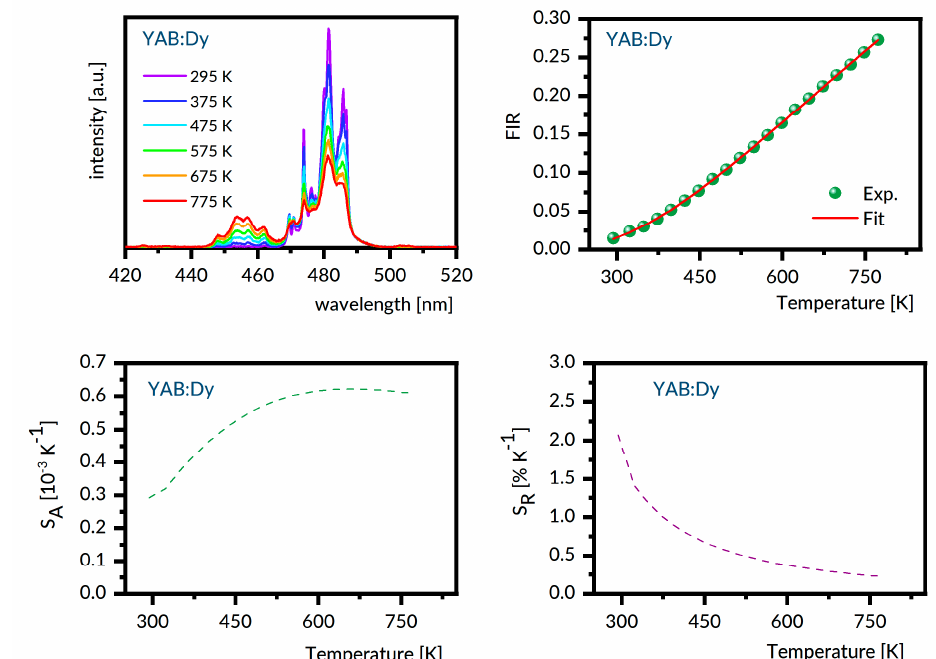
Figure 7. YAB:Dy emission spectra recorded at several different temperatures ( upper left ), the plot of FIR versus temperature ( upper right ), the temperature dependence of S A ( lower left ), and the temperature dependence of S R ( lower right ).